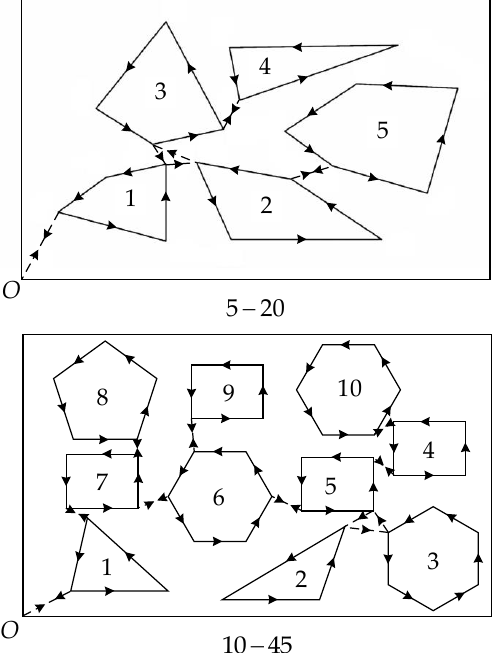
Figure 9. The optimal path graphs obtained by RLSGA on the test problems.